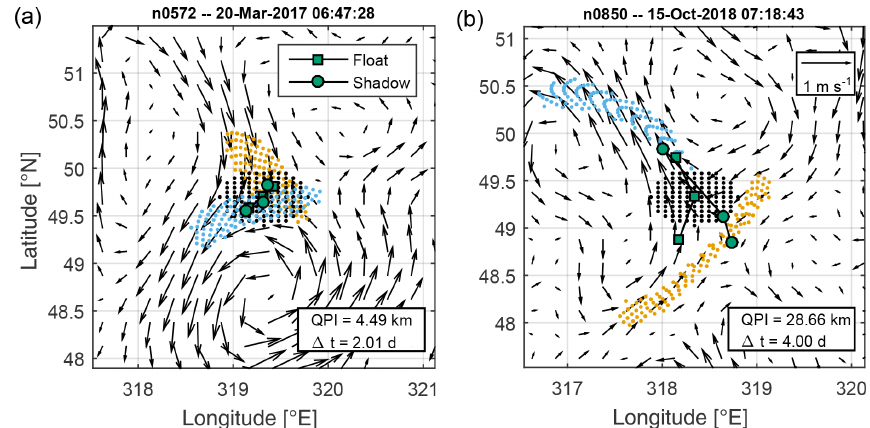
Figure 2. Example true (squares) and shadow (circles) float trajectories for (a) a small quasi-planktonic index (QPI) and (b) a large QPI. In both panels, altimetric geostrophic currents are shown as vectors, initial particle locations are black dots, and final forward (backward) particle locations are blue (orange) dots. The QPI and derivative time window are indicated in the lower right-hand corner.